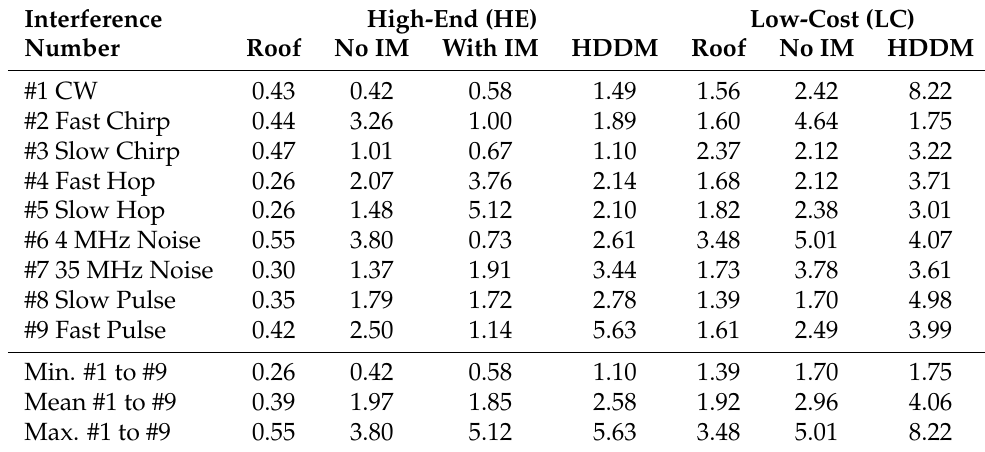
Table 3. 95% Horizontal position error